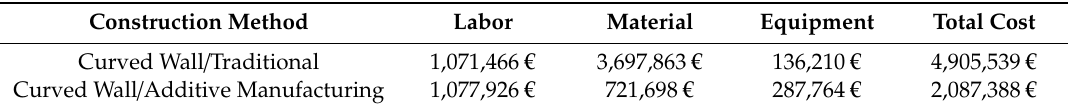
Table 2. Traditional manufacturing versus additive manufacturing: the distribution of labour, material, and equipment costs for concrete curved wall construction. (Data Reproduced from [45]).